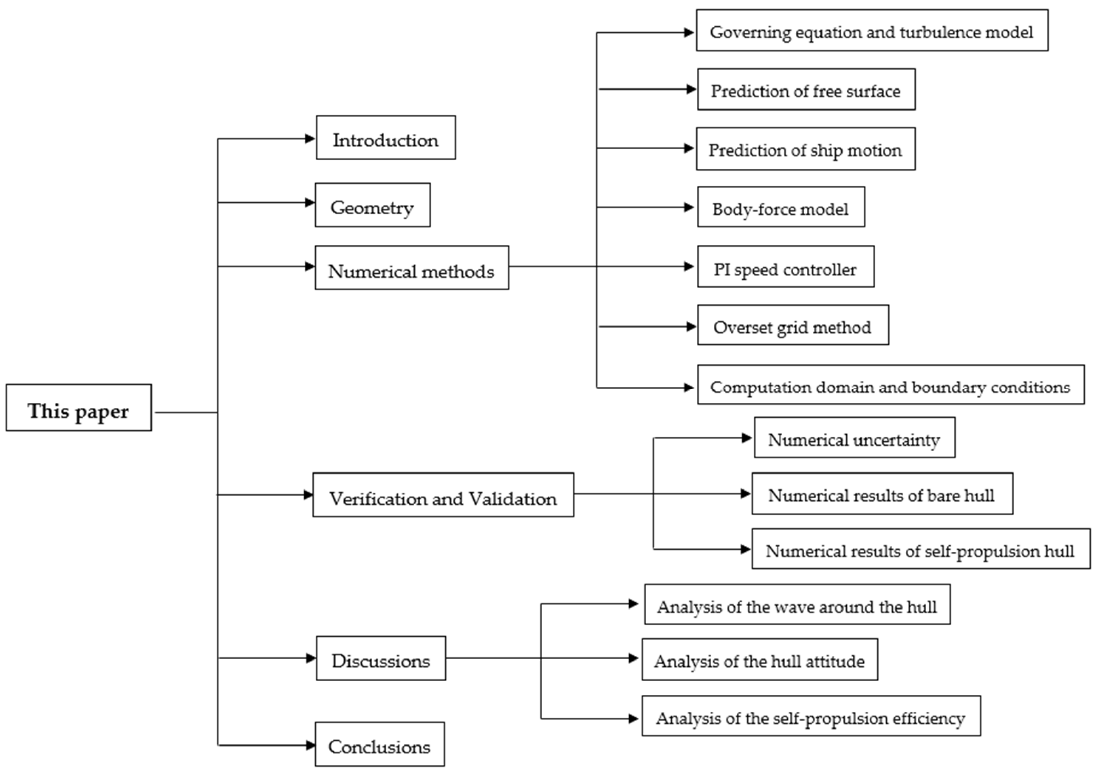
Figure 1. The main content of this paper.